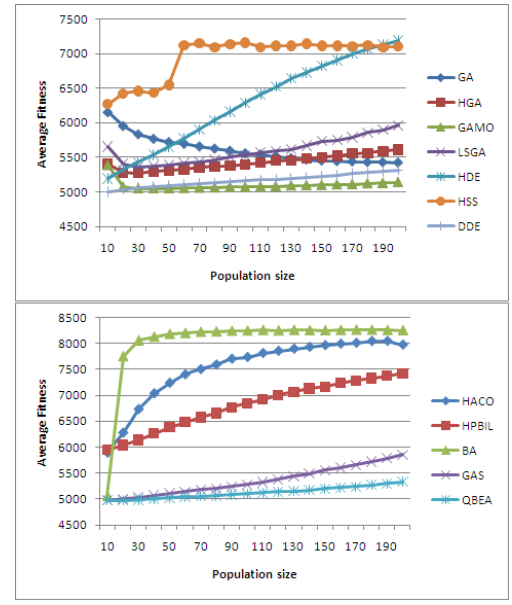
Fig. 6. Results – average fitness – instance 10. The values have been computed based on 30 different executions for each population size { 10 , 20 , ..., 200 }. For stop criterion we use 60